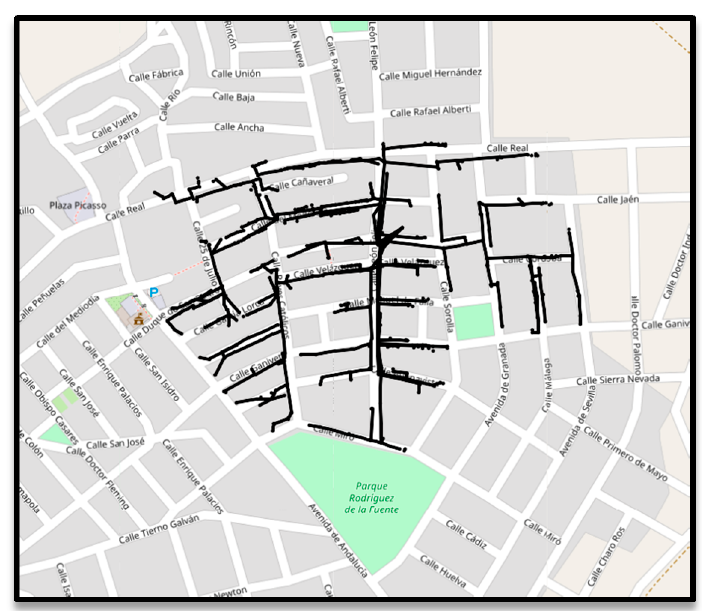
Figure 2. PF variation curve depending on the active power generated.